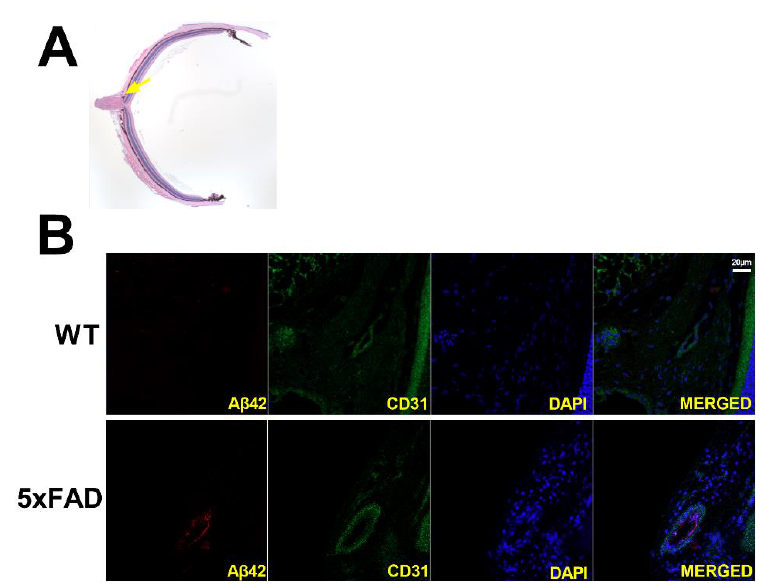
Figure 6. ( A ) Representative H&E-stained transverse retinal section and yellow arrow highlighting area of interest. Amyloid angiopathy is presented in transverse retinal sections of wild-type (WT) and five- familial Alzheimer’s disease ( 5XFAD) mice ( B ). Amyloid-beta 42 ( Aβ42) is presented in and five-familial Alzheimer’s disease (5XFAD) mice ( B ). Amyloid-beta 42 (A β 42) is presented in red, red, endothelial cells in green, and nuclei in blue. Scale bar, 20 μm. endothelial cells in green, and nuclei in blue. Scale bar, 20 µ